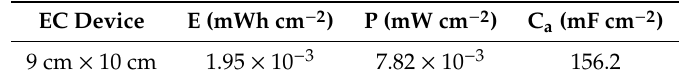
Table 3. Calculation of energy density, energy power density and areal capacitance of the fabricated electrochromic